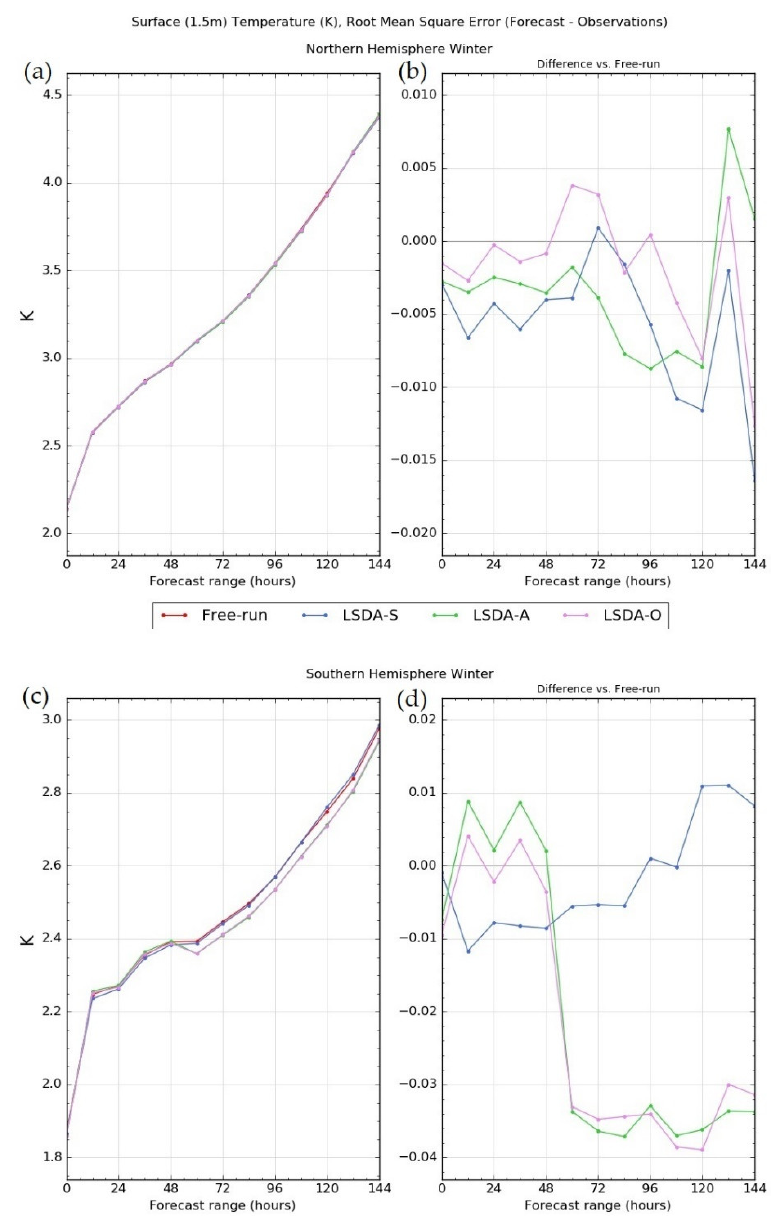
Figure 2. Winter forecasts compared to observations. Root mean squared errors or RMSE (panels a , c ) in surface (1.5 m) temperatures (Kelvin) computed for global forecasts against ground-based SYNOP observations for all forecast ranges up to T+144 h. Shown in this figure are the control run without LSDA or open-loop (red) and the experiments: assimilation of pseudo-observations of screen-level temperature and humidity only (blue), assimilation of ASCAT only (green), and assimilation of both observation types (pink). Panels ( b ) and ( d ) show the RMSE difference between the control and the three experiments such that a negative result means improvement of the experiment over the control. Panels ( a ) and ( b ) are for the Northern hemisphere winter period, 1 December, 2017 to 19 February, 2018 (81 days). Panels ( c ) and ( d ) are for the Southern hemisphere, 15 July, 2018 to 15 October, 2018 (92 days).